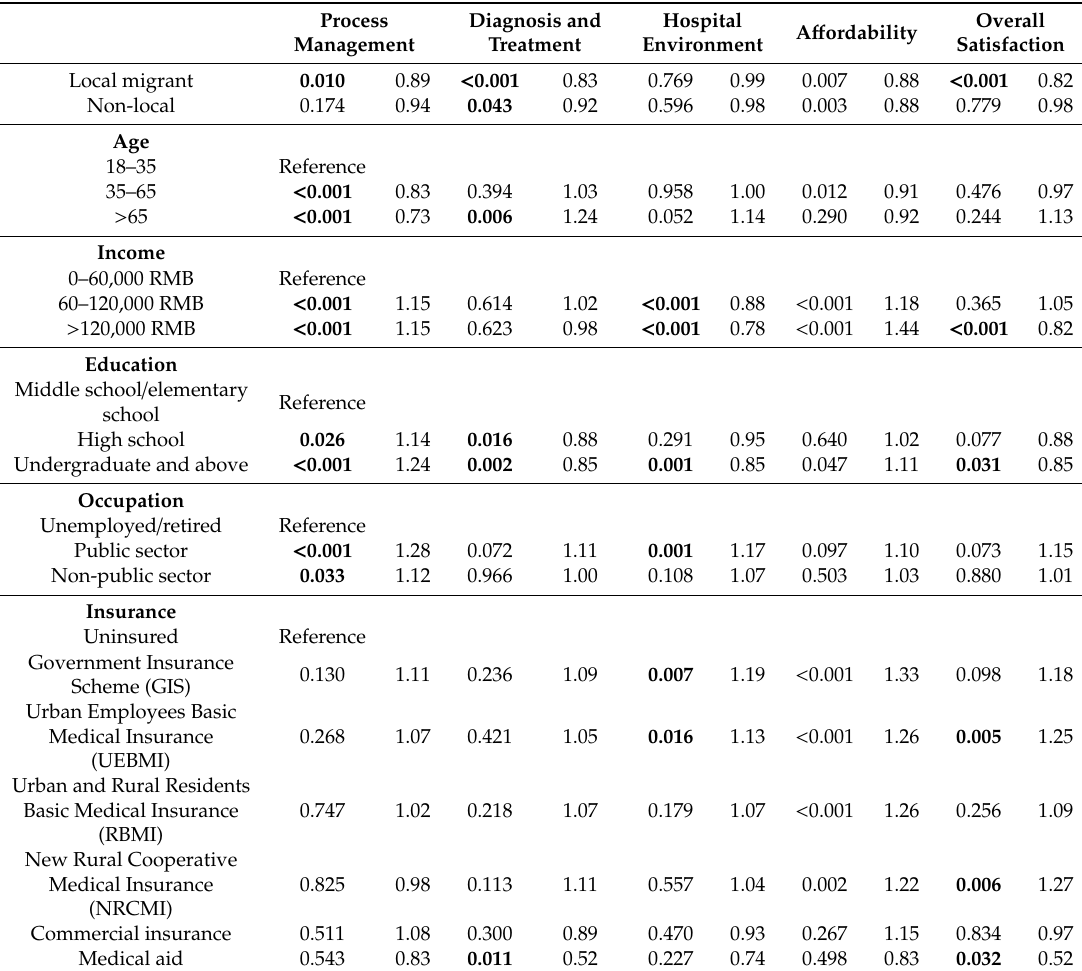
Bold characteristics indicate p value <